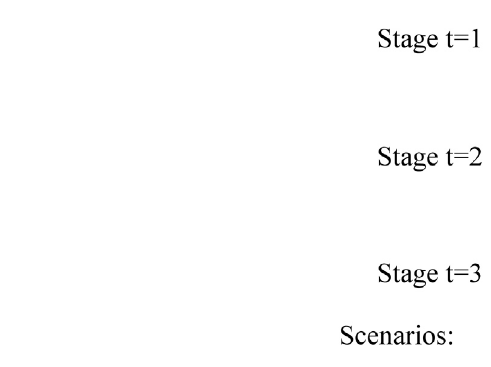
FIGURE 7 | Illustration of a scenario tree with 3 stages, 4 scenarios, seven